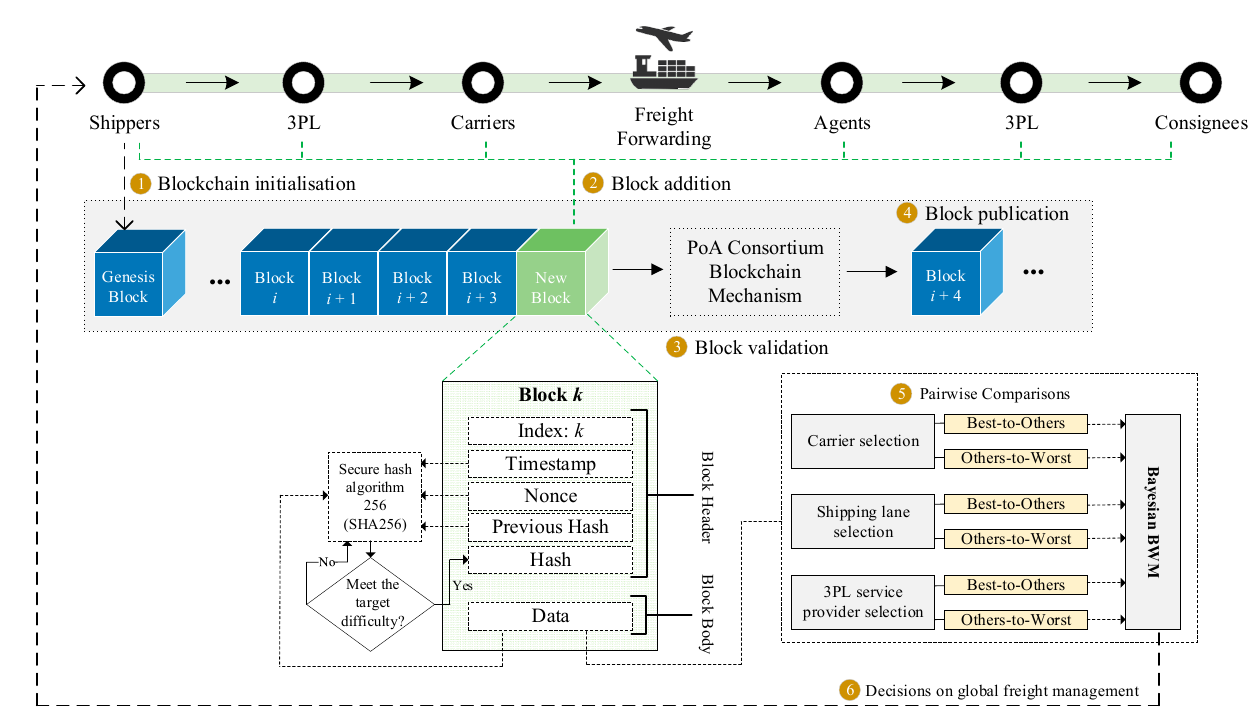
Figure 4. Schematic diagram of the IB-GFDF.